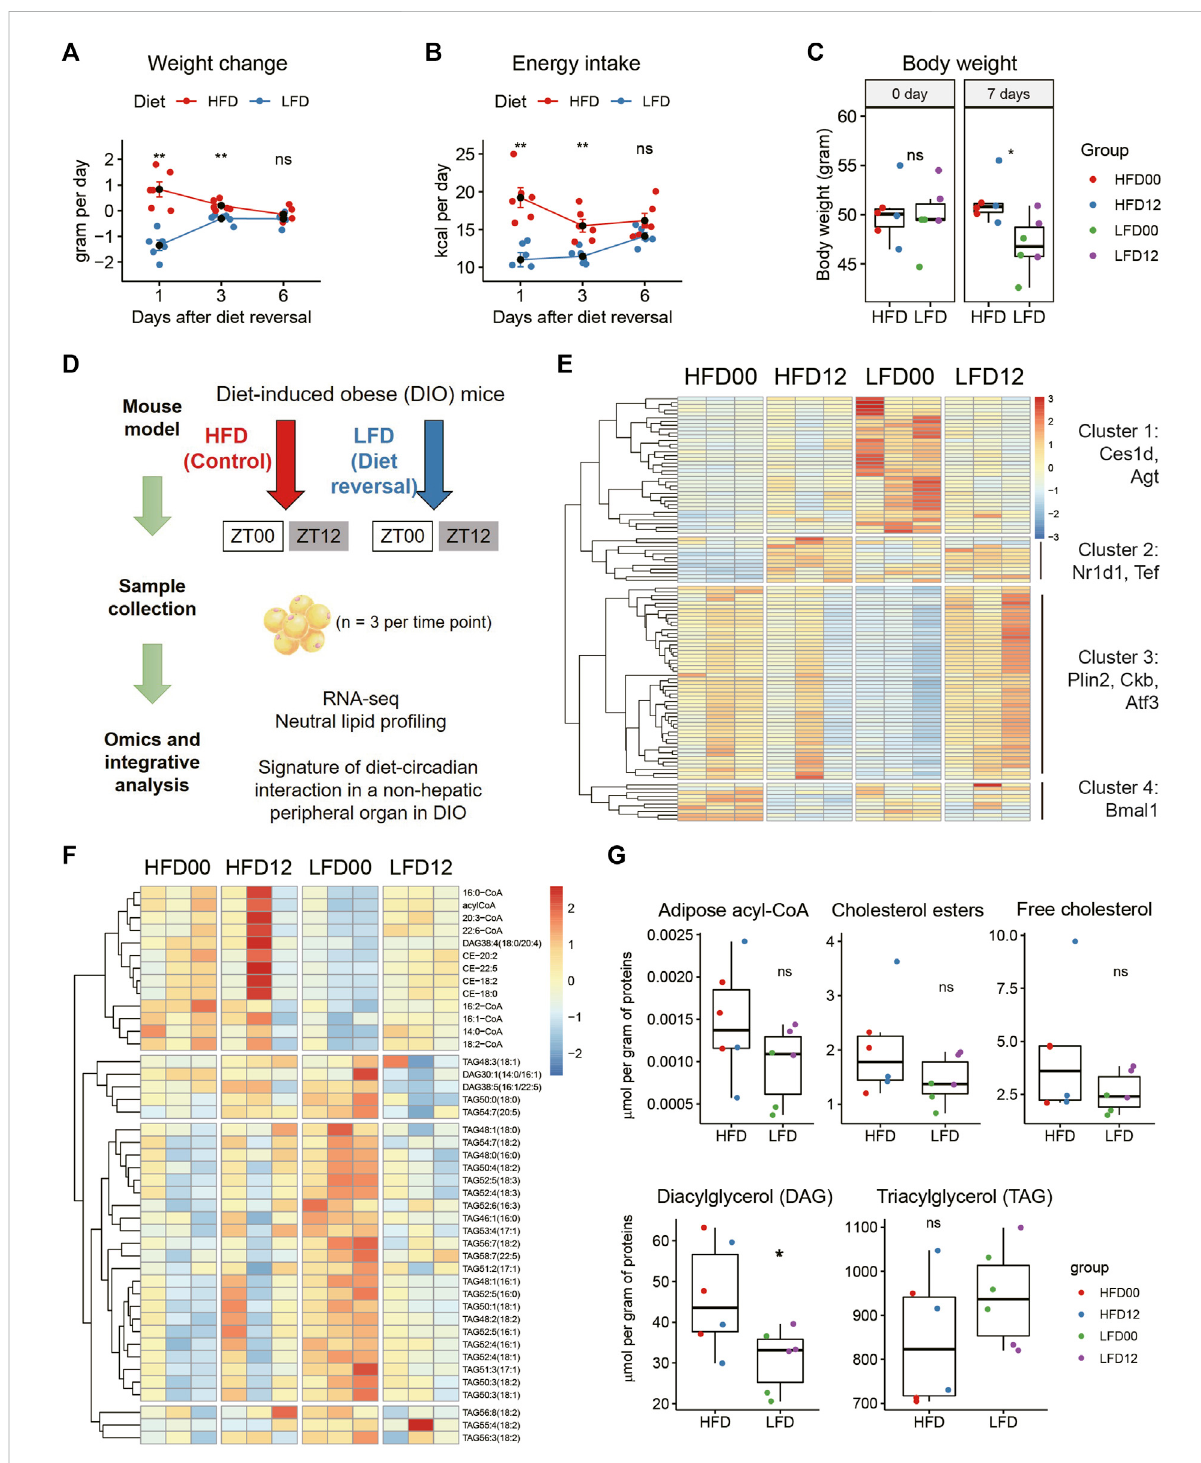
FIGURE 1 Identi fi cation of transcripts and lipids altered by diet reversal and time of day in adipose tissue of diet-induced obese mice. Twelve male DIO mice were randomly assigned to high-fat diet(HFD, Control)and low-fatdiet(LFD, Diet-reversal)for 7 days. (A – C) Weight change (A) , energy intake (B) , and body weight (C) before and after 7 days of diet reversal. (D) Study design. Mice were sampled at ZT0 and ZT12. VAT samples were also subjected to RNA-seq and quantitative mass spectrometry analyses for neutral lipids and acyl-CoAs. (E) Representative differentially expressed genes from pairwise comparisons between the four groups (adjusted p -value < 0.05). (F) Differentially regulated lipids in VAT (adjusted p -value < 0.05, Tukey ’ sHSD test). (G) Total concentrations oflipid species by class inVAT. DIO, diet-induced obese;VAT, visceraladiposetissue; ZT, zeitgeber time. HFD00, HFD mouse samples collected at ZT0; HFD12, HFD samples collected at ZT12; LFD00, LFD mouse samples collected at ZT0; LFD12, LFD samples collected at ZT12. Data are represented as mean ± SEM and jittered points. One-way ANOVA and unpaired t -test, * p <